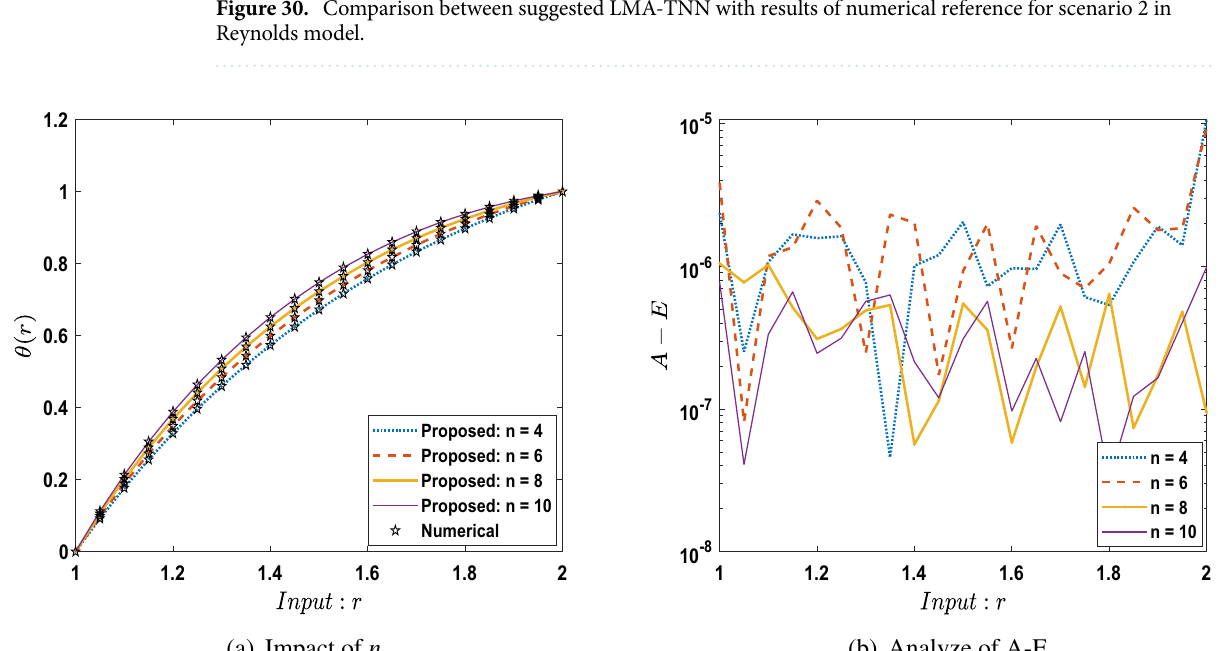
Figure 31. Comparison between suggested LMA-TNN with results of numerical reference for scenario 3 in Reynolds